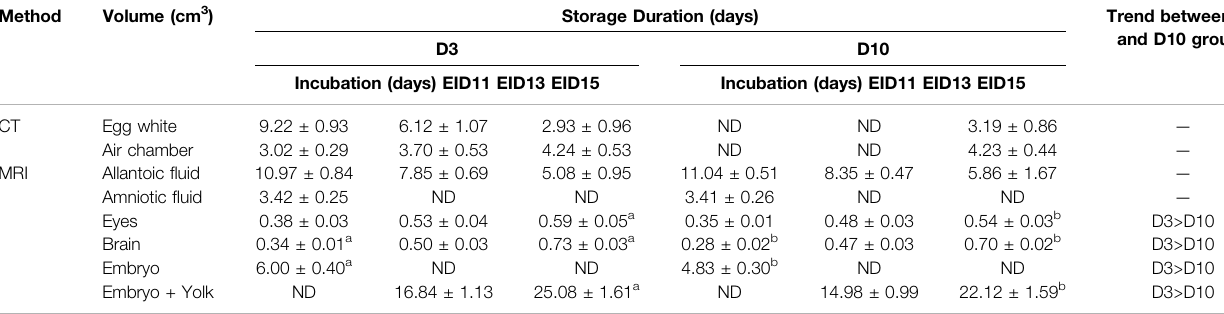
TABLE 3 | Effect of egg storage on embryonic development.